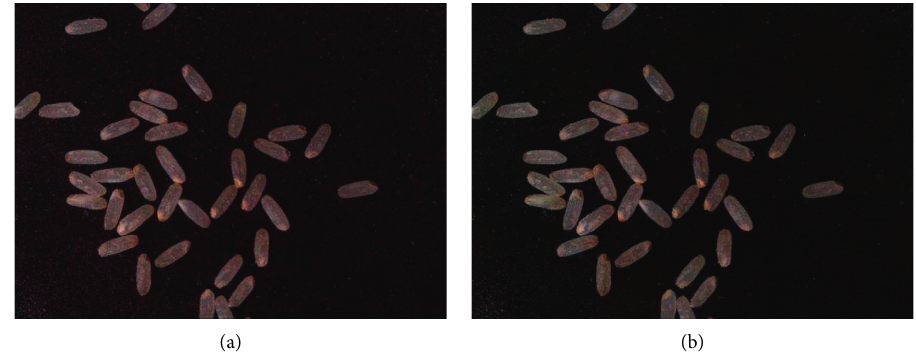
Figure 2: Image comparison after segmented transformation. (a) The original image. (b) The image processed by top-hat